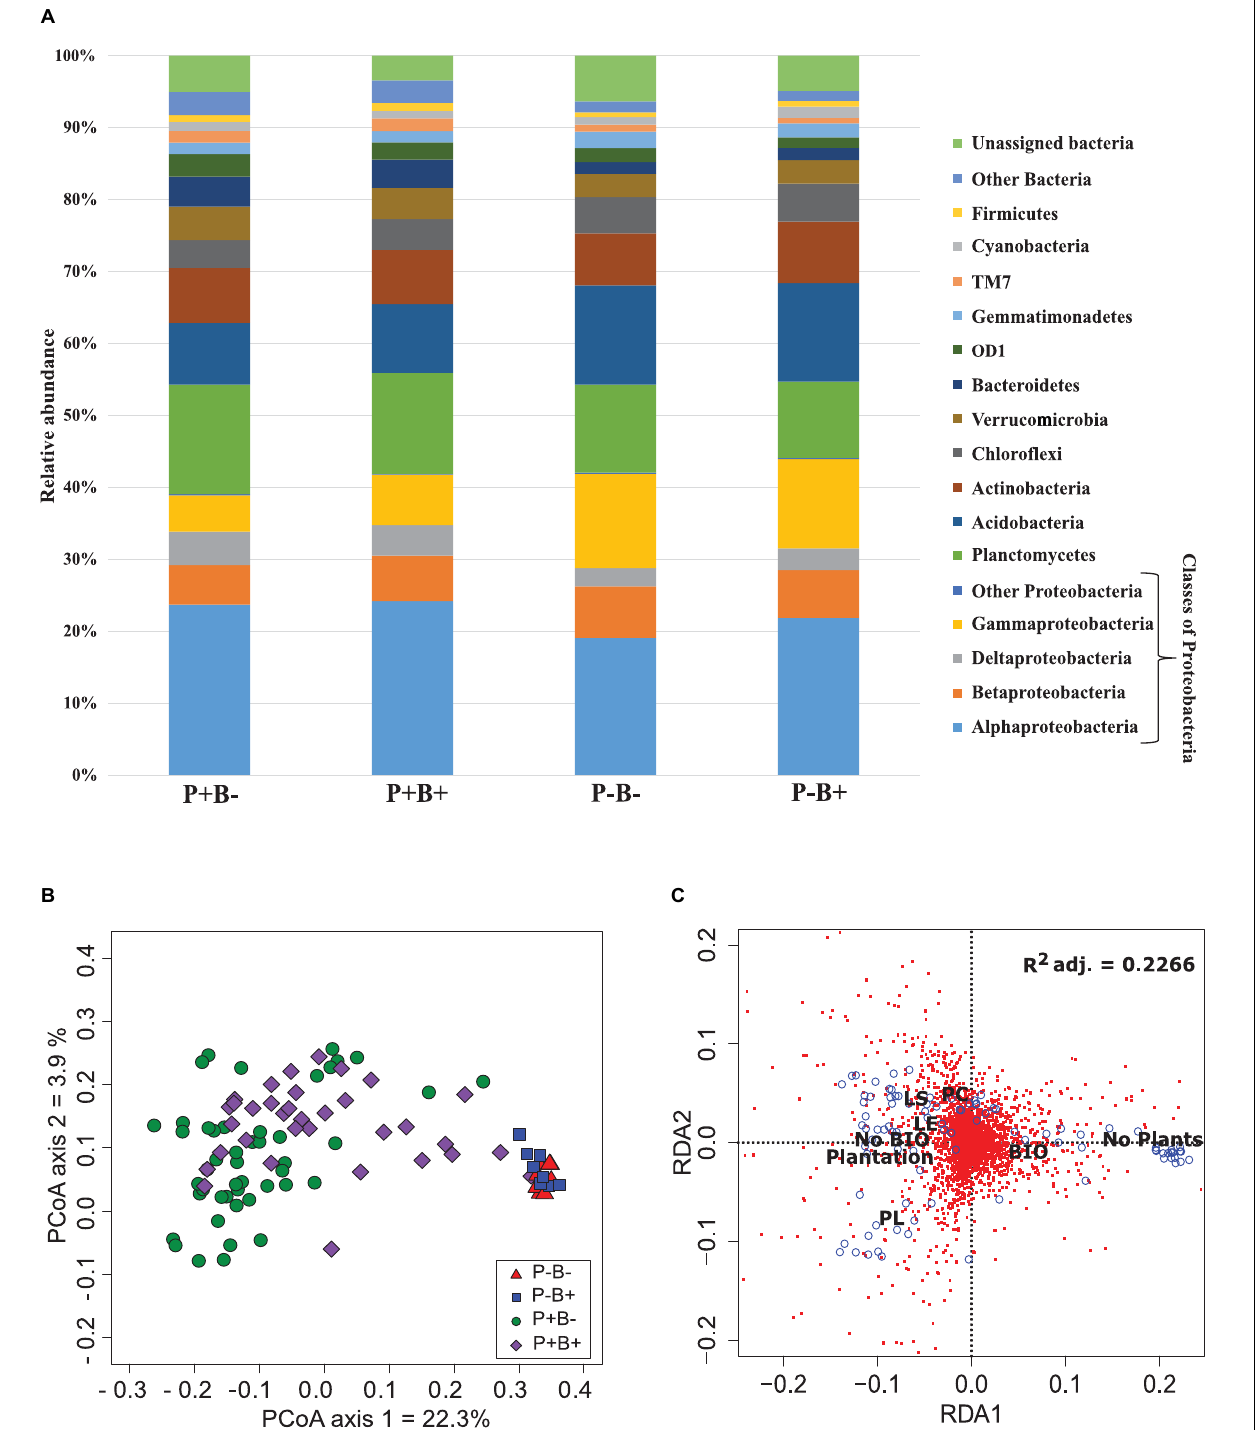
Frontiers in Microbiology |